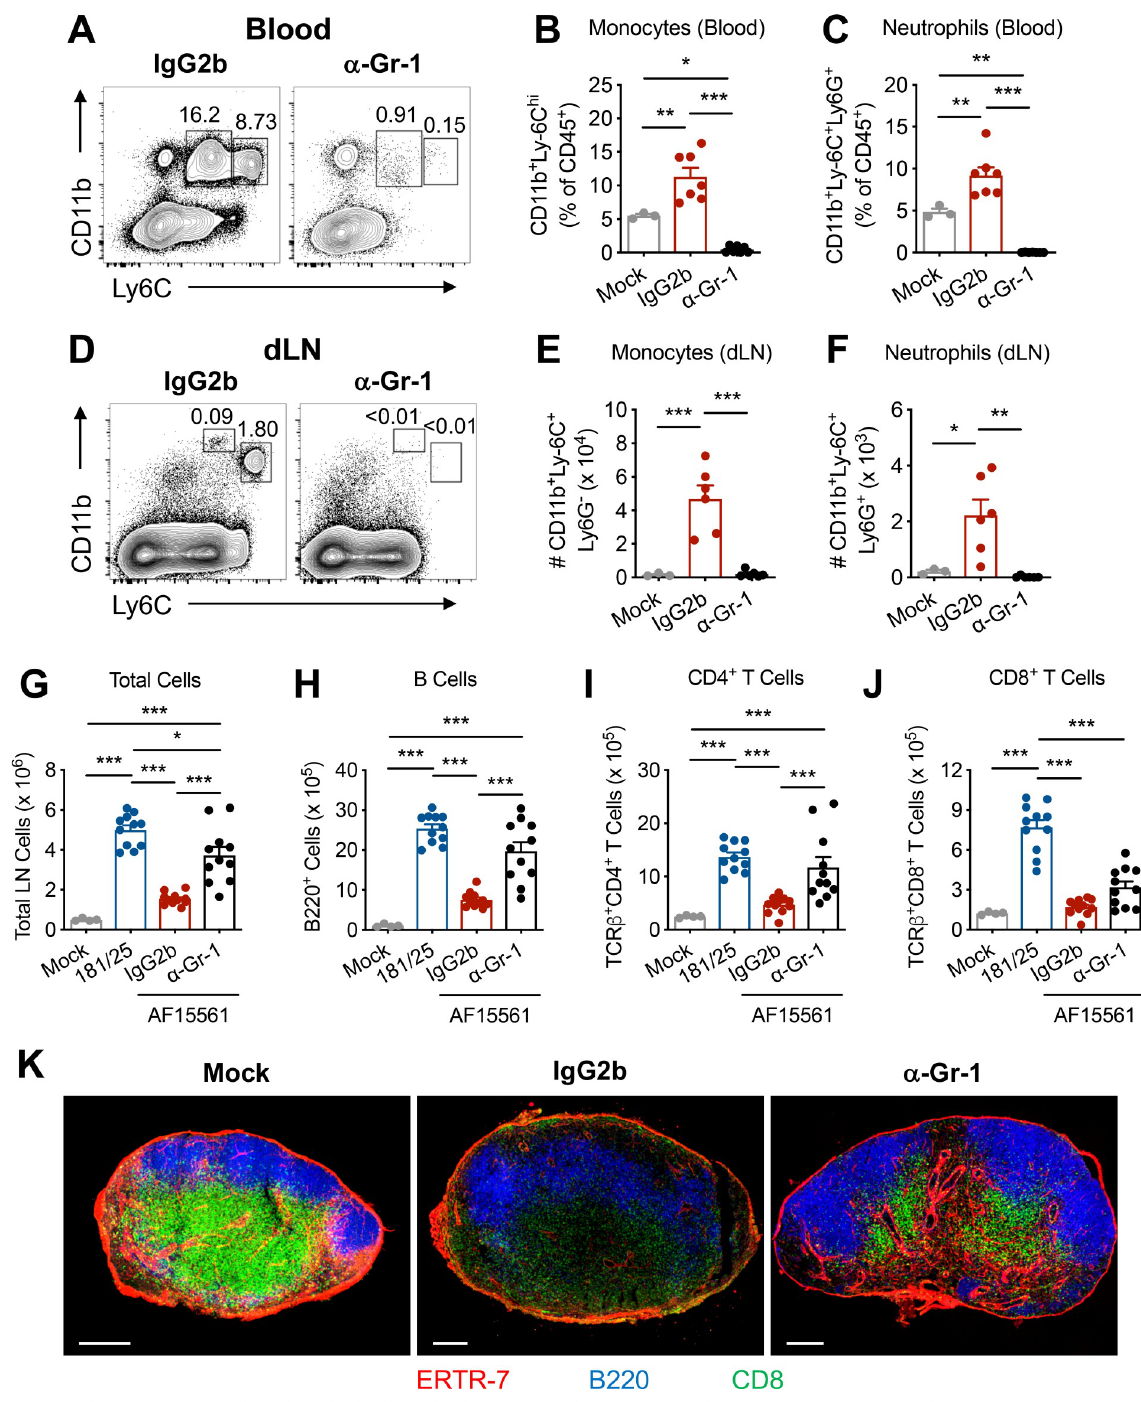
Fig 2. Delaying the early influx of myeloid cells to the dLN prevents lymphocyte depletion and restores dLN architecture. C57BL/6 mice were left untreated or treated with 300–500 μ g of IgG2b isotype control mAb or anti-Gr-1 mAb via intraperitoneal injection one day prior to inoculation with 10 3 PFU of CHIKV 181/25 or AF15561 in the left footpad. ( A ) Representative flow cytometry plots and percentages of ( B ) CD11b + Ly6C hi monocytes or ( C ) CD11b hi Ly6C + Ly6G + neutrophils in the blood. ( D ) Representative flow cytometry plots and numbers of ( E ) CD11b + Ly6C hi monocytes or ( F ) CD11b hi Ly6C + Ly6G + neutrophils in the dLN. Data are combined from two independent experiments (n = 3 (mock) to 7 per group). At 5 dpi, the dLN was analyzed for ( G ) total cells, ( H ) CD19 + B220 + B cells, ( I ) TCR β + CD4 + T cells, and ( J ) TCR β + CD8 + T cells. Data are combined from 3 independent experiments (n = 4 (mock) or 11 per group). ( K ) Frozen dLN sections were stained for ERTR7 + stromal cells (red), B220 + B cells (blue), or CD8 + T cells (green). Errors bars represent mean ± SEM. Data in ( G-J ) are